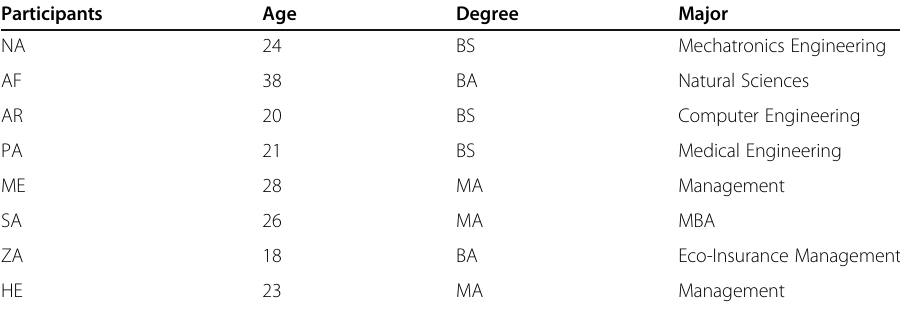
Table 1 A configuration of the participants with their Pseudonyms